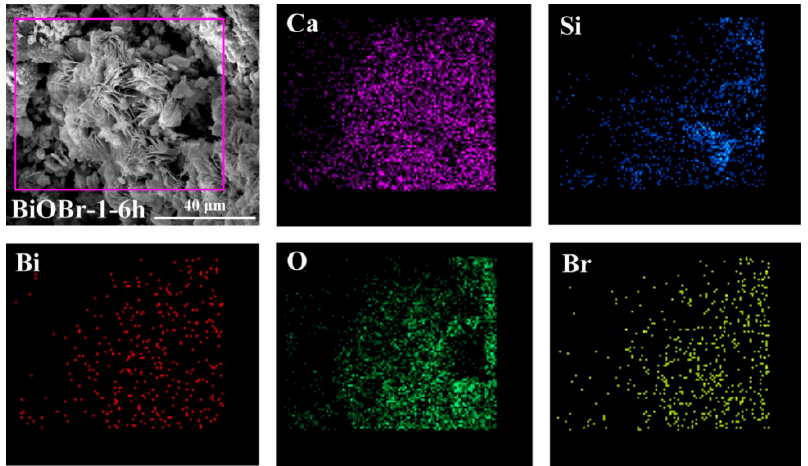
Figure 8. SEM image and EDS-mapping images of BiOBr crystals.